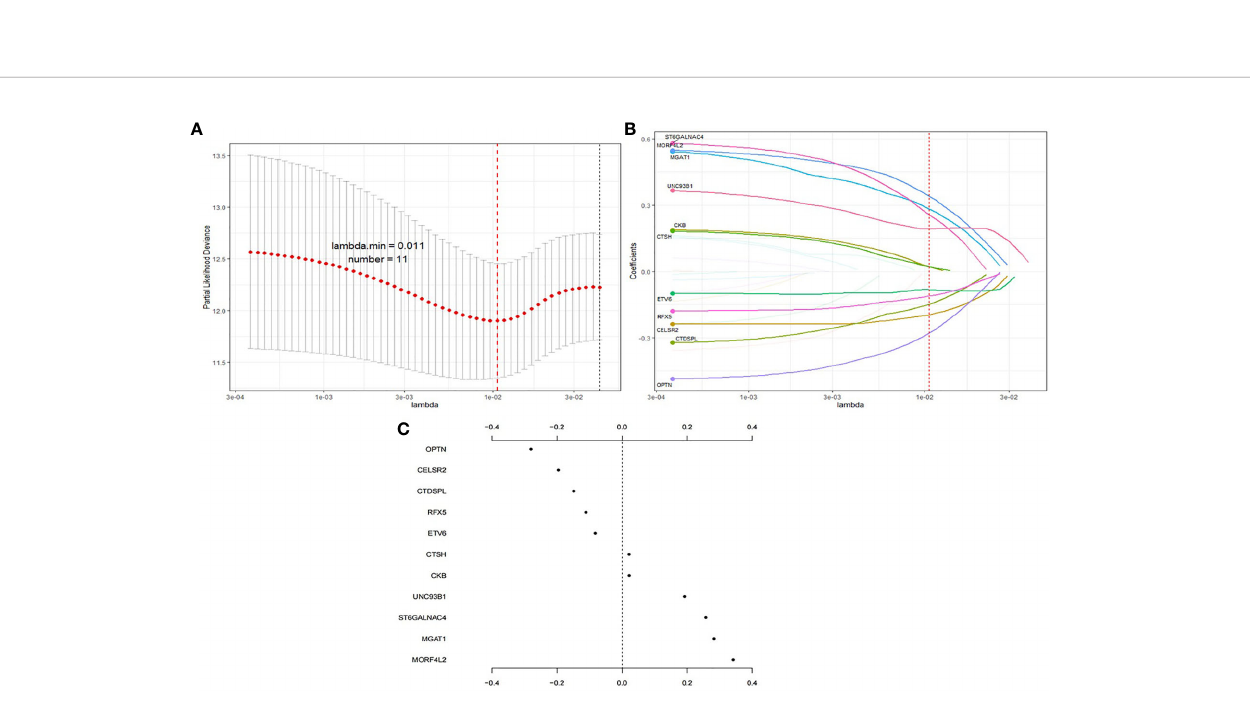
FIGURE 3 | Process of gene signature construction using LASSO. (A) Penalty parameter tuning conducted by 10-fold cross-validation. (B) 11 hub genes with (C) their coef fi cients.